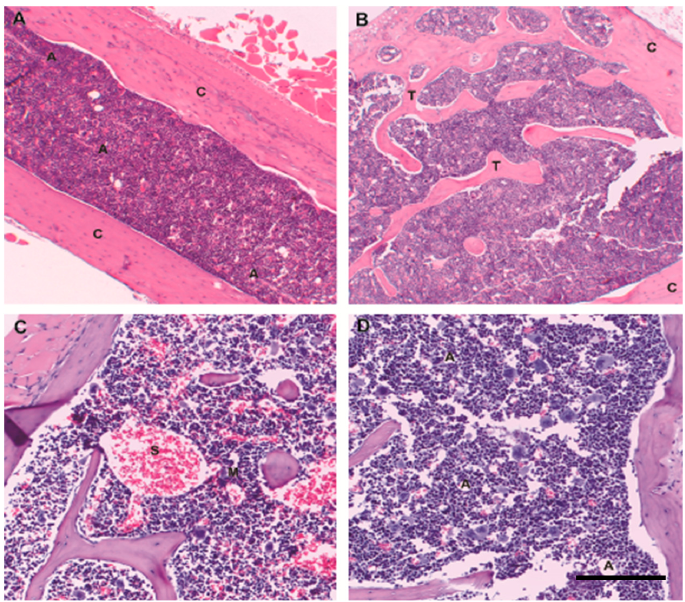
Figure 2. Mouse marrow architecture in youth and age: Hematopoiesis in mice is present throughout the skeleton. Photomicrographs from C57BL6 wild-type animals. ( A ) Mouse hematopoietic marrow the